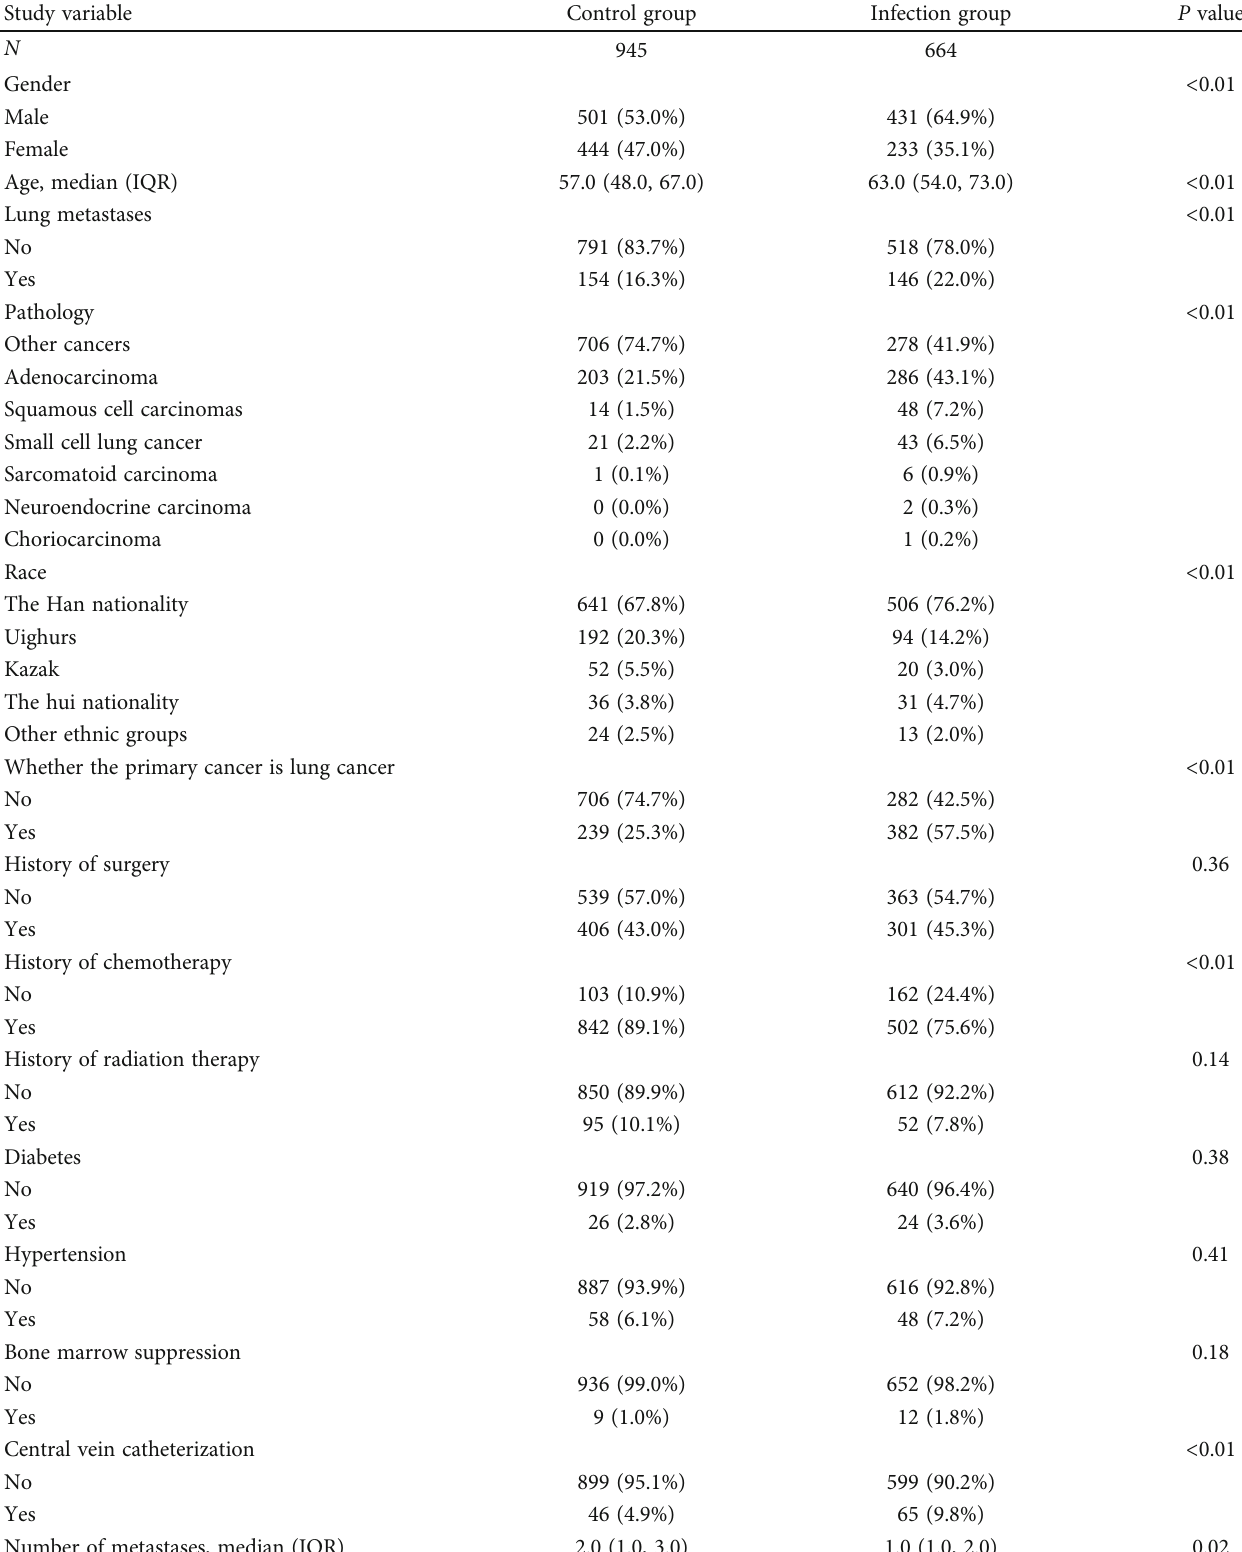
Table 1: The training dataset predicted a bivariate relationship between variables and concurrent pulmonary